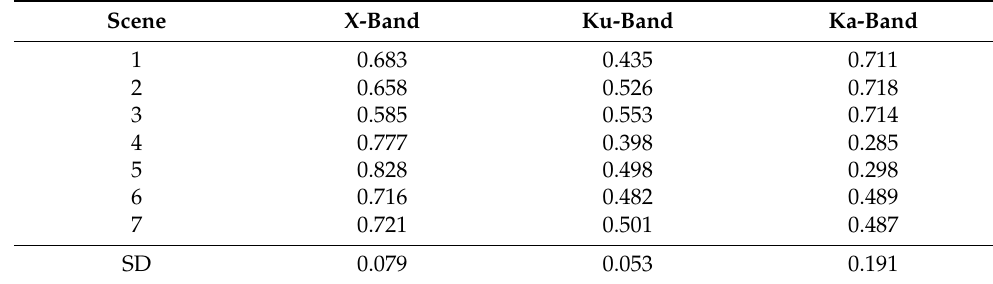
Table 3. SSIM evaluation results of ISAR image.